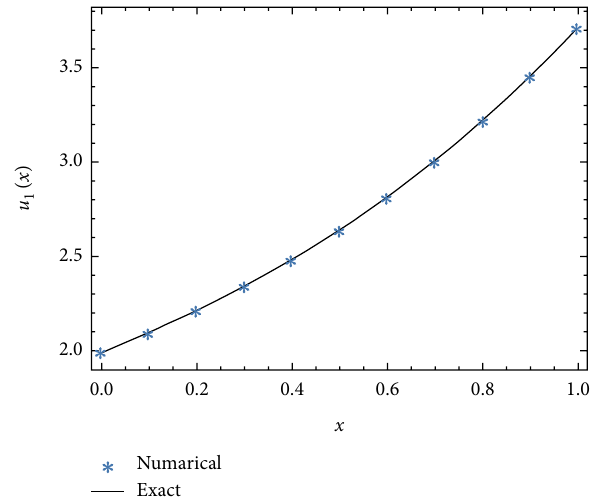
Figure 6: The exact and numerical solutions of 2 for system (69).